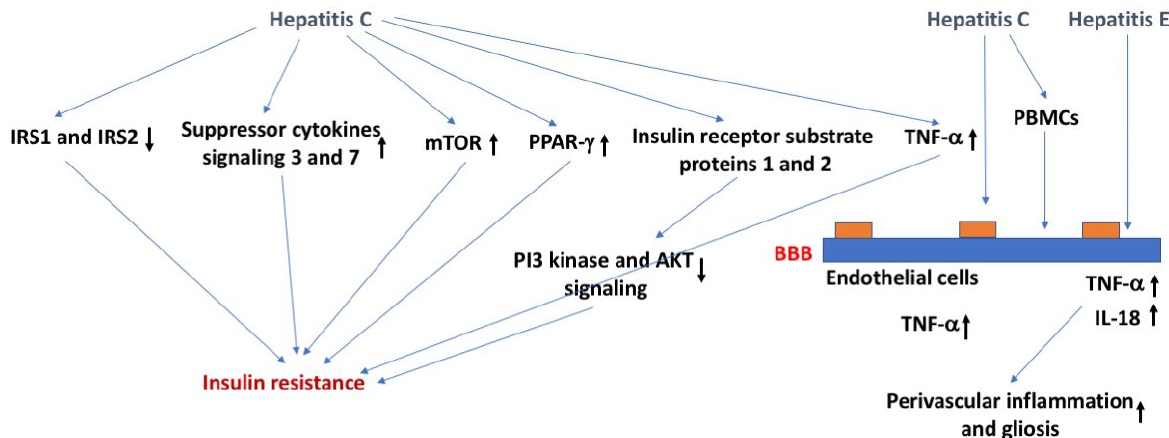
Figure 3. Hepatitis, insulin resistance, and the BBB. Hepatitis C might cause insulin resistance via distinct pathways. Effects of Hepatitis C on the BBB might result in enhanced TNF- α levels. These effects might involve effects of PBMCs on the BBB. Hepatitis E might cause perivascular inflammation and gliosis by increasing brain levels of TNF- α and IL-18. The arrows in bold indicate the direction of the effects. For more details, see